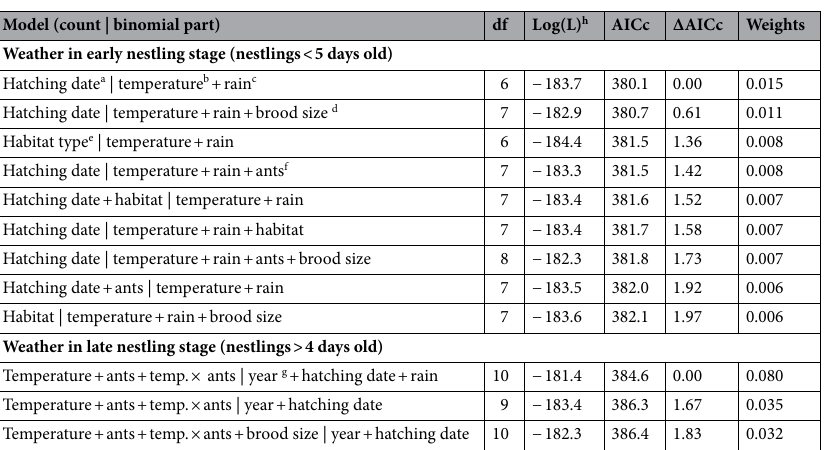
Table 1. Selection of hurdle negative binomial models (ΔAICc < 2) testing blowfly Protocalliphora azurea infestation of 129 Wood Warbler Phylloscopus sibilatrix nests (response variable) depending on weather in early or late nestling stages. The count part with negative binomial distribution estimated changes in the number of blowflies in infested nests, and the hurdle binomial tested the likelihood of blowfly presence (package pscl 92,93 ). A null model had only fixed intercepts on the count and binomial parts. a Relative hatching date of nestlings (days from the median hatching date in a year); b an average of daily means (°C); c a sum of daily sums (mm); d the number of nestlings hatched; e habitat type (deciduous or mixed deciduous-coniferous); f presence or absence of ants in bird nests (as a factor); g study year (2018–2020; as a factor); h log-likelihood.